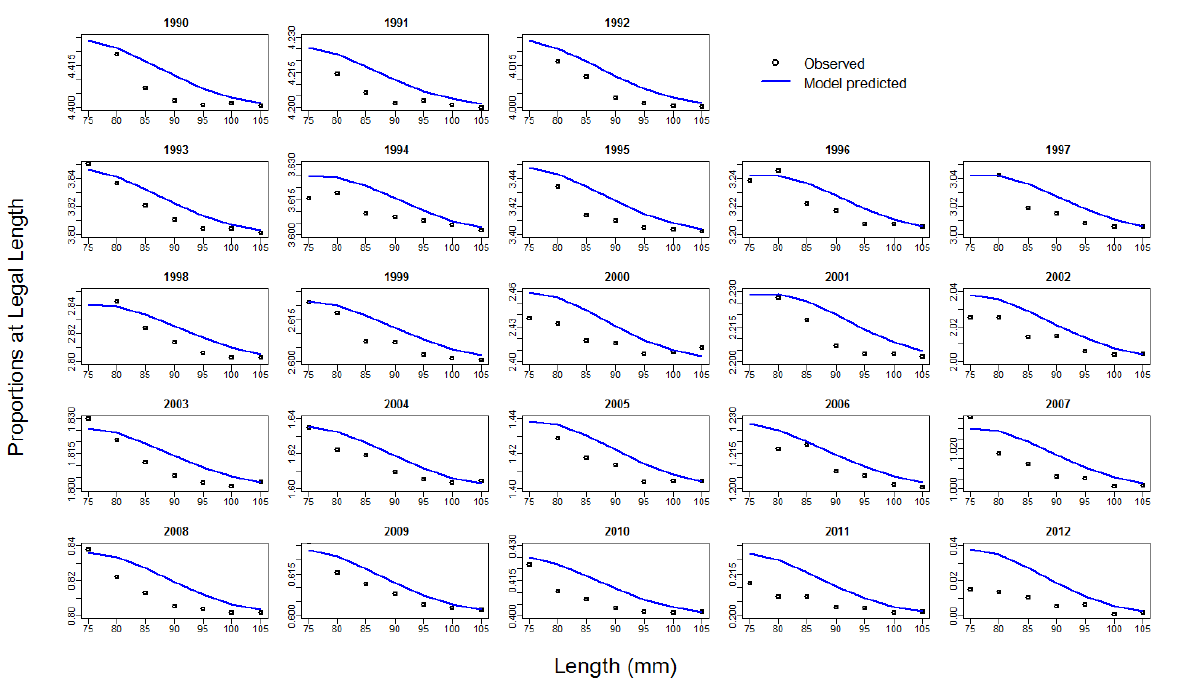
Figure A2.4. Comparison of model-predicted length proportions of legal sized oysters in Apalachicola Bay, Florida during fall (blue line) and observed length proportions of legal size oysters (black circles) in fisheries independent surveys conducted in fall by the Florida Department of Agriculture and Consumer